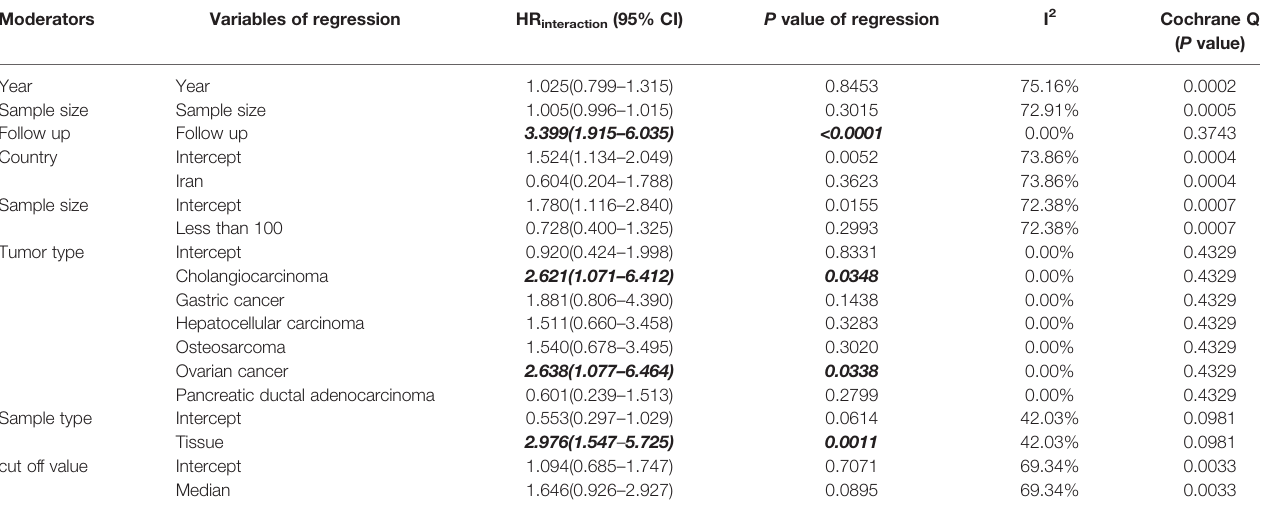
TABLE 6 | Meta-regression analysis of heterogeneity in TNM